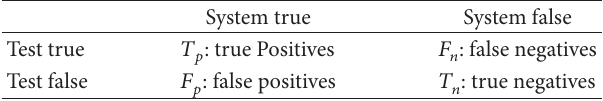
Table2:AconfusionmatrixforBSDoutput.“True”denotespositive cases, that is, the sentence